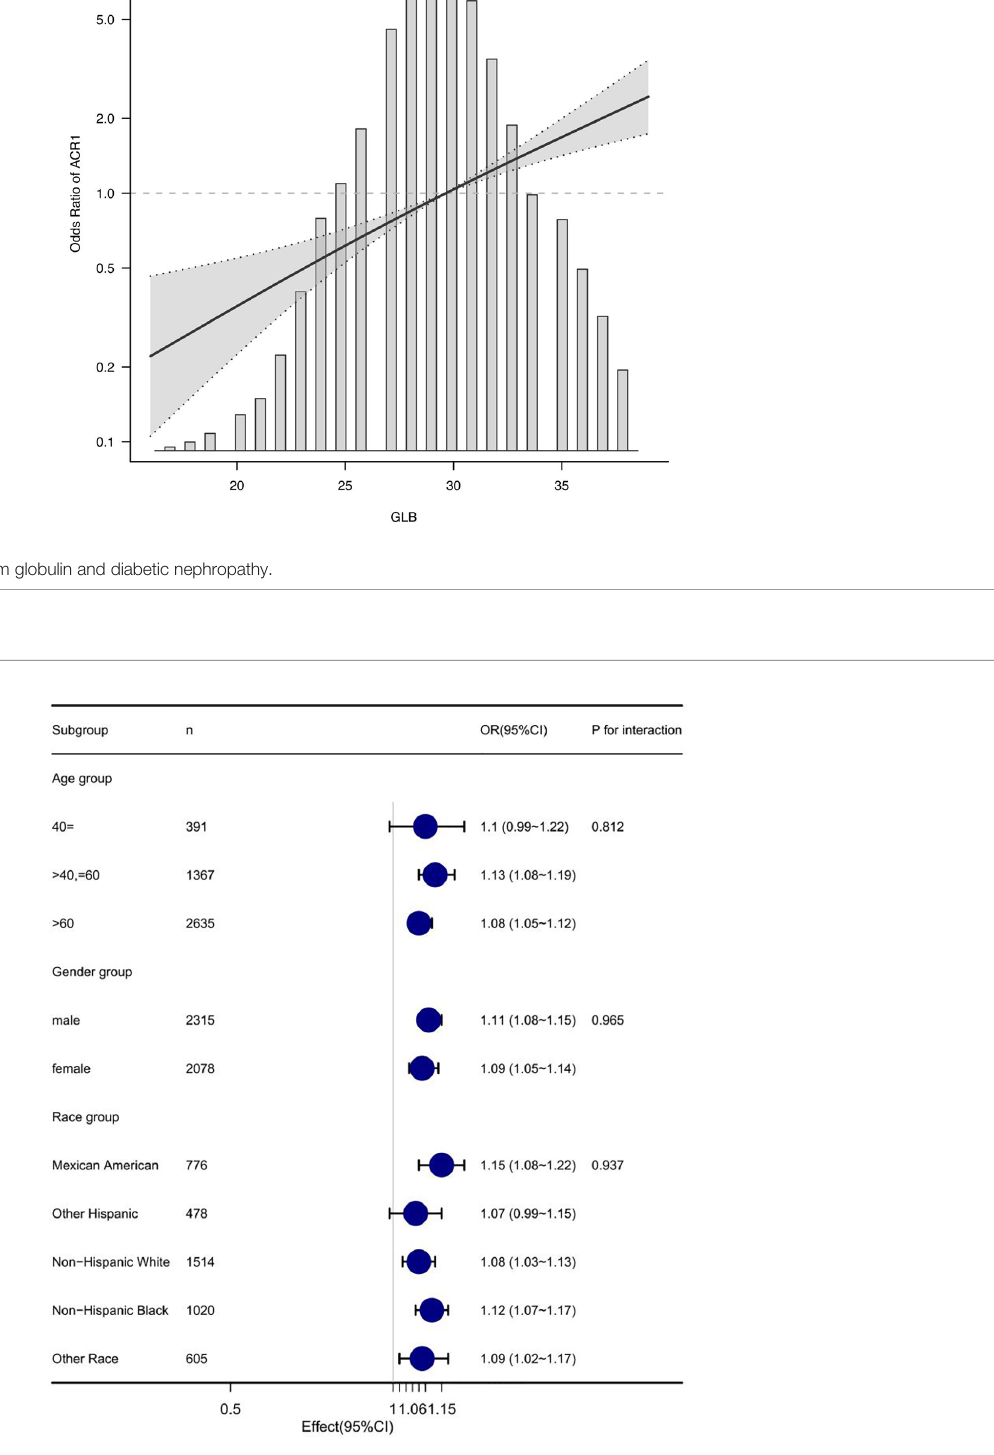
FIGURE 3 | Forest plot of serum globulin and diabetic nephropathy.